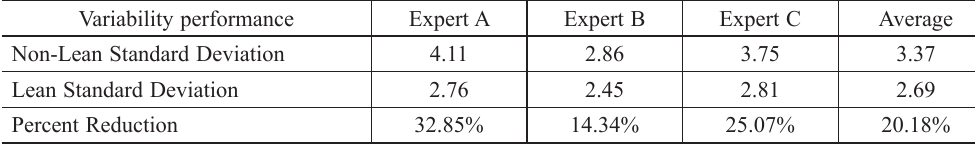
Table 8. Variability indicators of the simulation